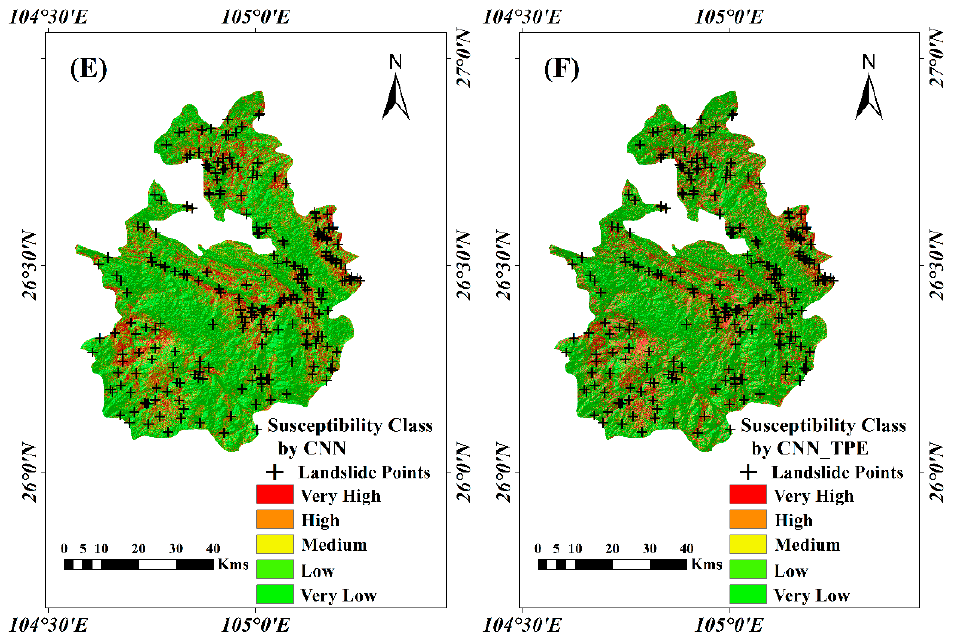
Figure 11. Landslide susceptibility maps based on ( A ) DNN, ( B ) DNN_TPE, ( C ) RNN, ( D ) RNN_TPE, ( E ) CNN, and ( F ) CNN_TPE.